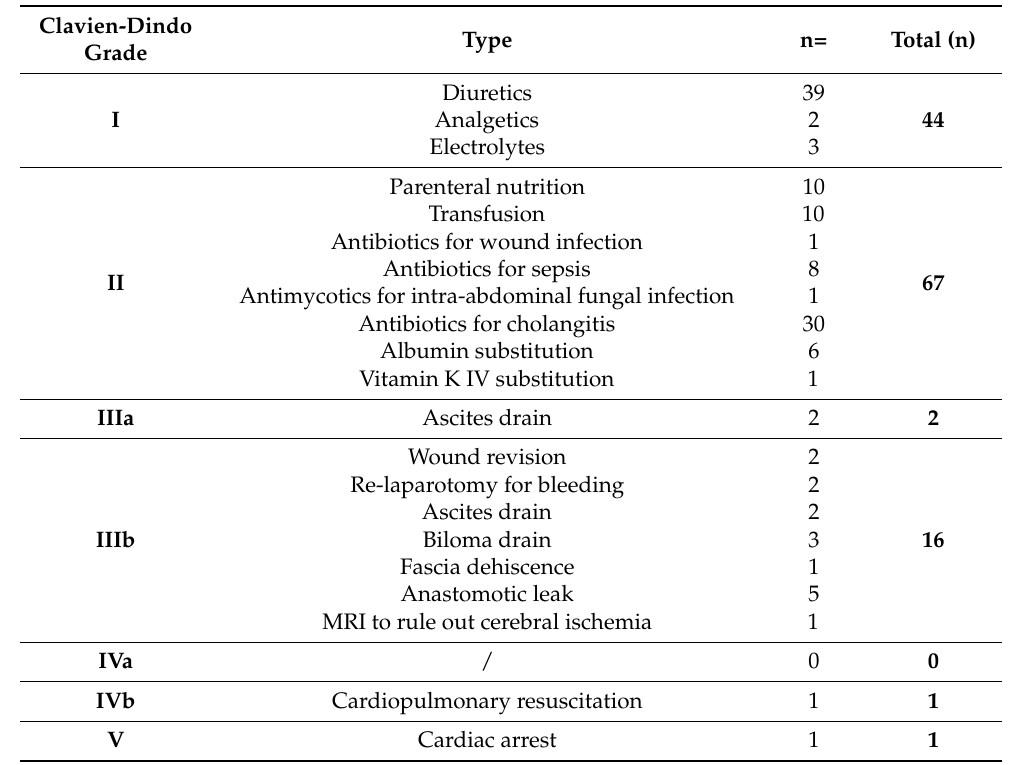
Table 1. Information on all unexpected events in the postoperative management of biliary atresia following Kasai procedure and grading according to the Clavien–Dindo